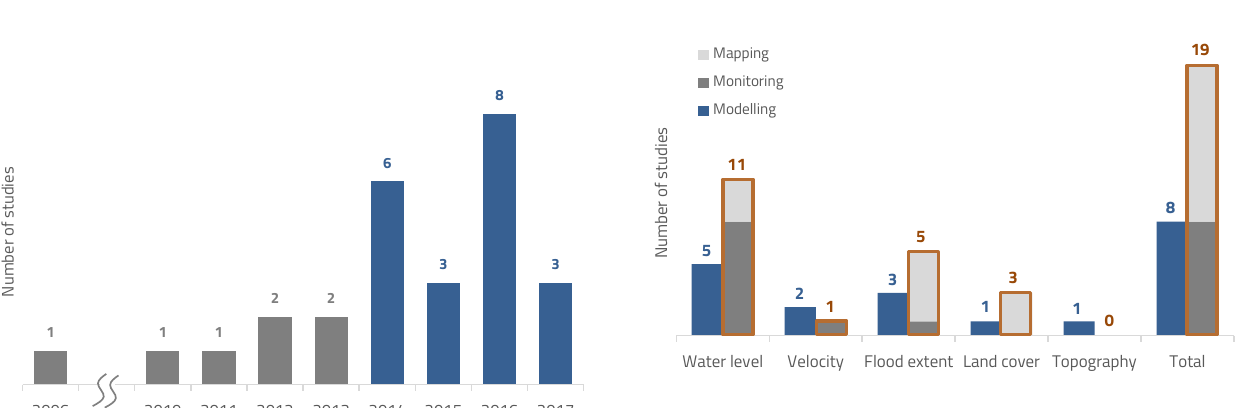
Figure 5. Number of studies analysed per flood-related variable per category: mapping, monitoring and